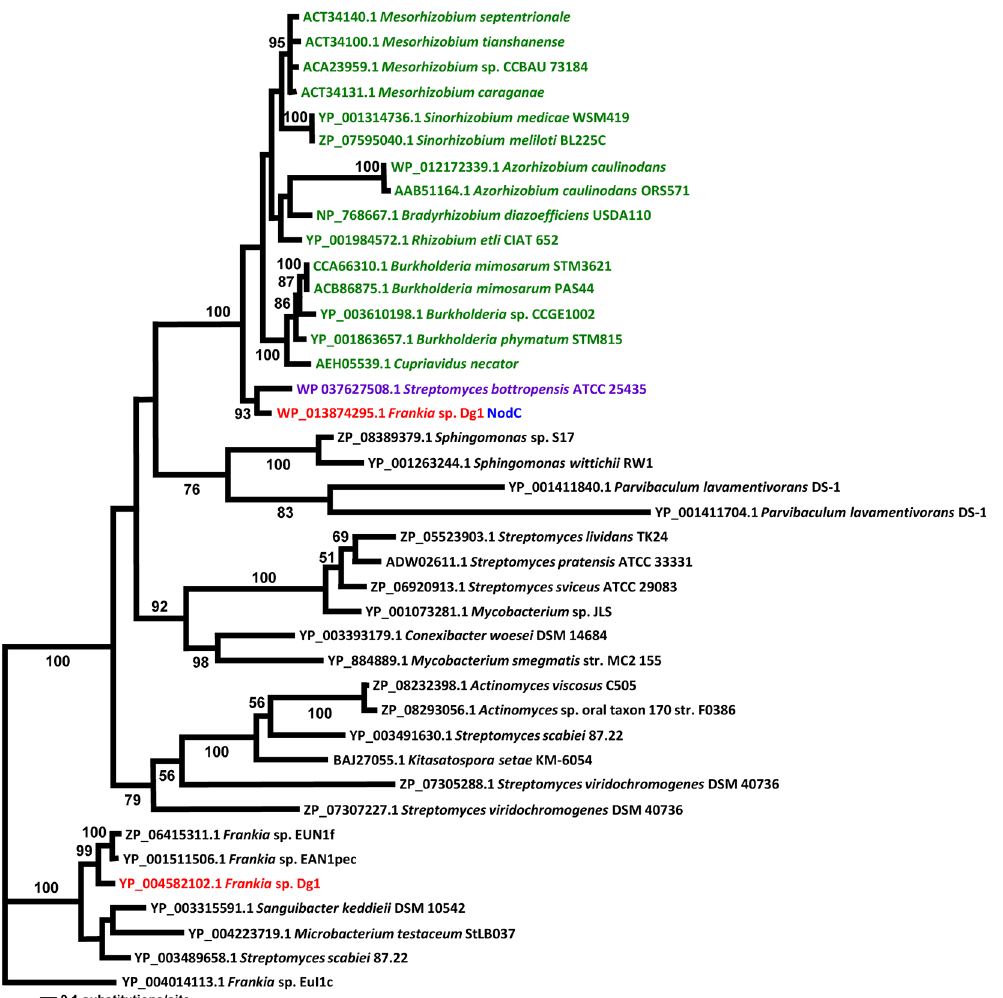
Fig 4. Maximum Likelihood trees of NodC proteins. All rhizobial sequences are given in green, all sequences from Dg1 are given in red, sequences from Streptomyces bottropensis are given in purple. The Dg1 NodC sequence is indicated in blue. All sequences used for the phylogenetic analysis are given in S6